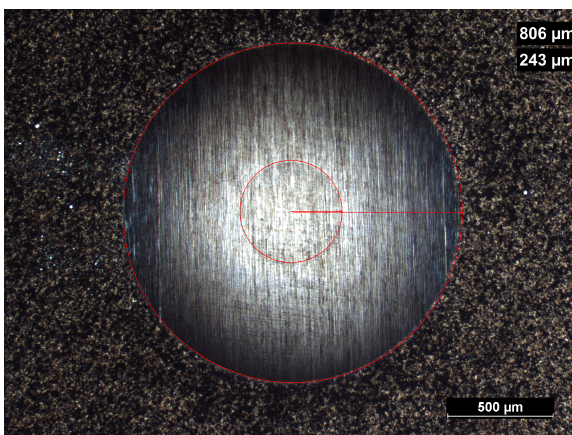
Figure 3. Calotest.